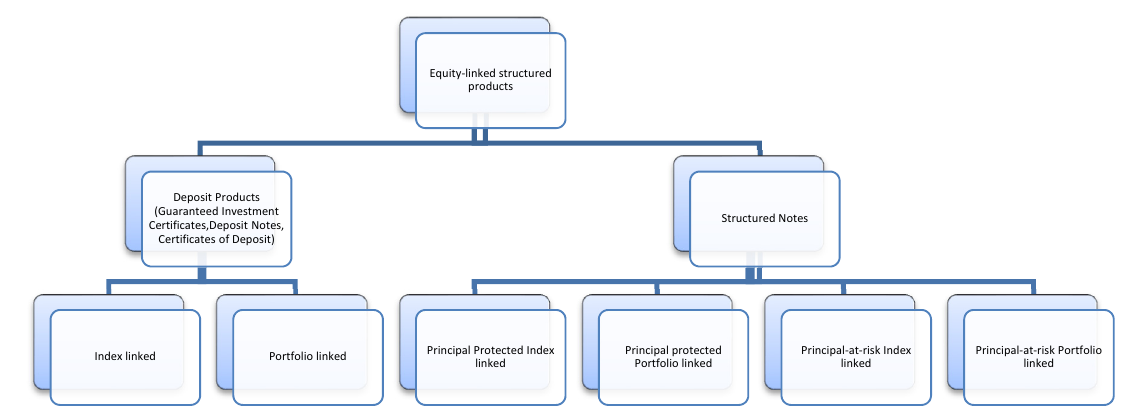
Figure 1. A generic typology of pay at maturity (PAM) equity-linked structured products.